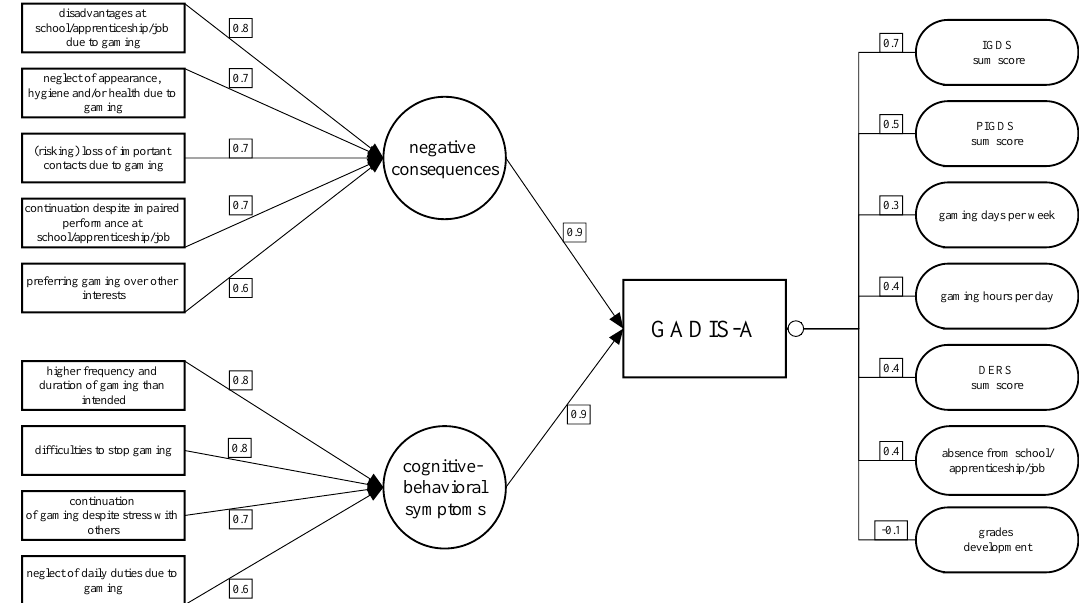
Figure 1. Factor loadings on two GADIS-A factors. GADIS-A = Gaming Disorder Scale for Adolescents, GADIS-A factor 1 = negative consequences due to gaming. Items loading on factor 1 as presented on the left side: 7-9, 6,3; GADIS-A factor 2 = cognitive-behavioral gaming symptoms. Items loading on factor 2 as presented on the left side: 1,2,4,5; IGDS = Internet Gaming Disorder Scale, PIGDS = Parental Internet Gaming Disorder Scale, DERS = Di ffi culties in Emotion Regulation Scale, Grades development = improvement of the sum of grades of the three main subjects during the past school year. Table 2. Exploratory Factor Analysis (EFA) and Confirmatory Factor Analysis (CFA), factor loadings, EFA communalities, and EFA explained variance proportions.